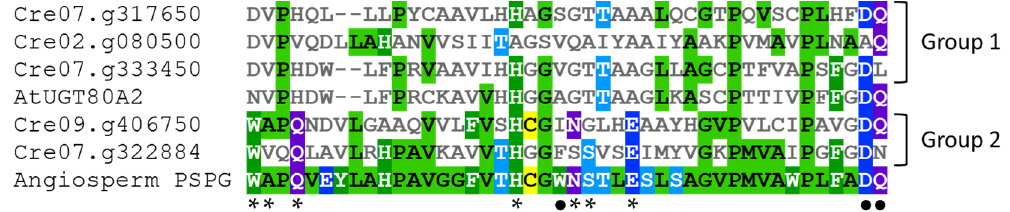
Figure 3. PSPG sequences alignment of the five C. reinhardtii UGTs with the PSPG sequence of the Arabidopsis UGT80A2 and the PSPG consensus sequence of angiosperm UGTs (according to [44]). The sequences were aligned using MView [53]. Amino acids are colored depending on their similarity. *: well-conserved amino acids with known function on UDP-sugar binding